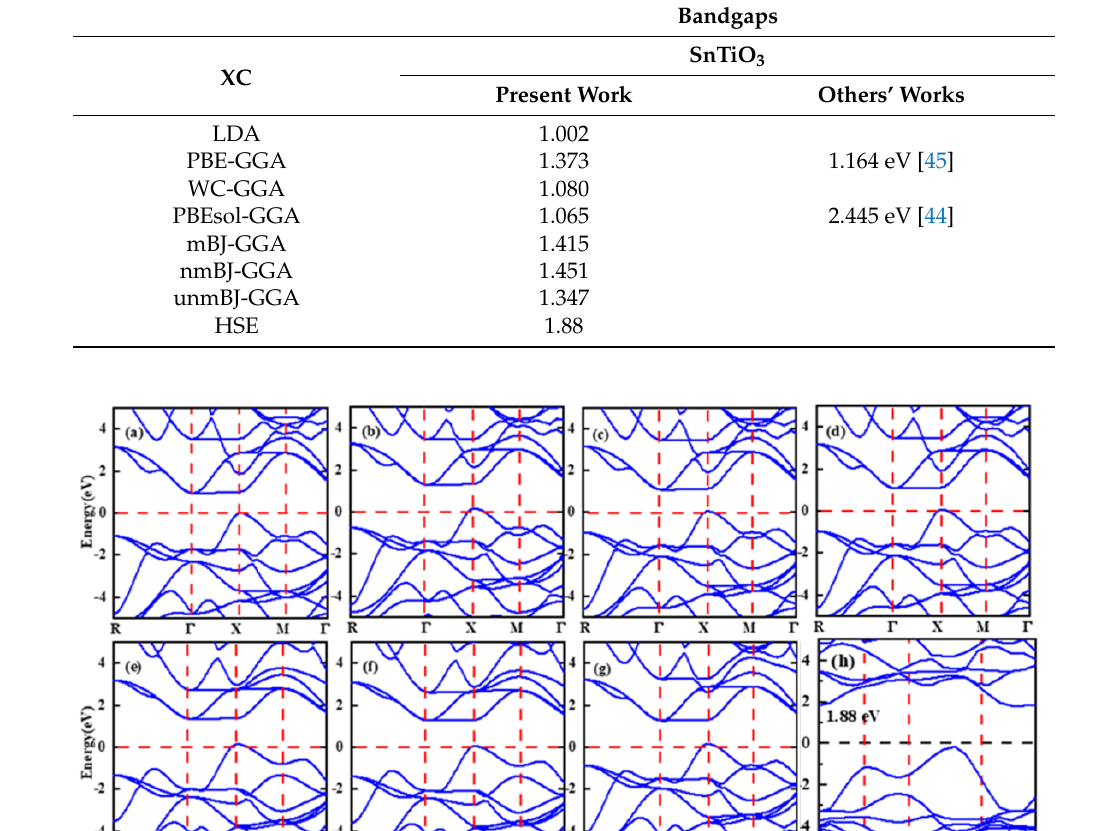
Table 3. Comparison between Calculated Bandgaps and Reported Theoretical and Experimental Bandgaps for SnTiO 3 .